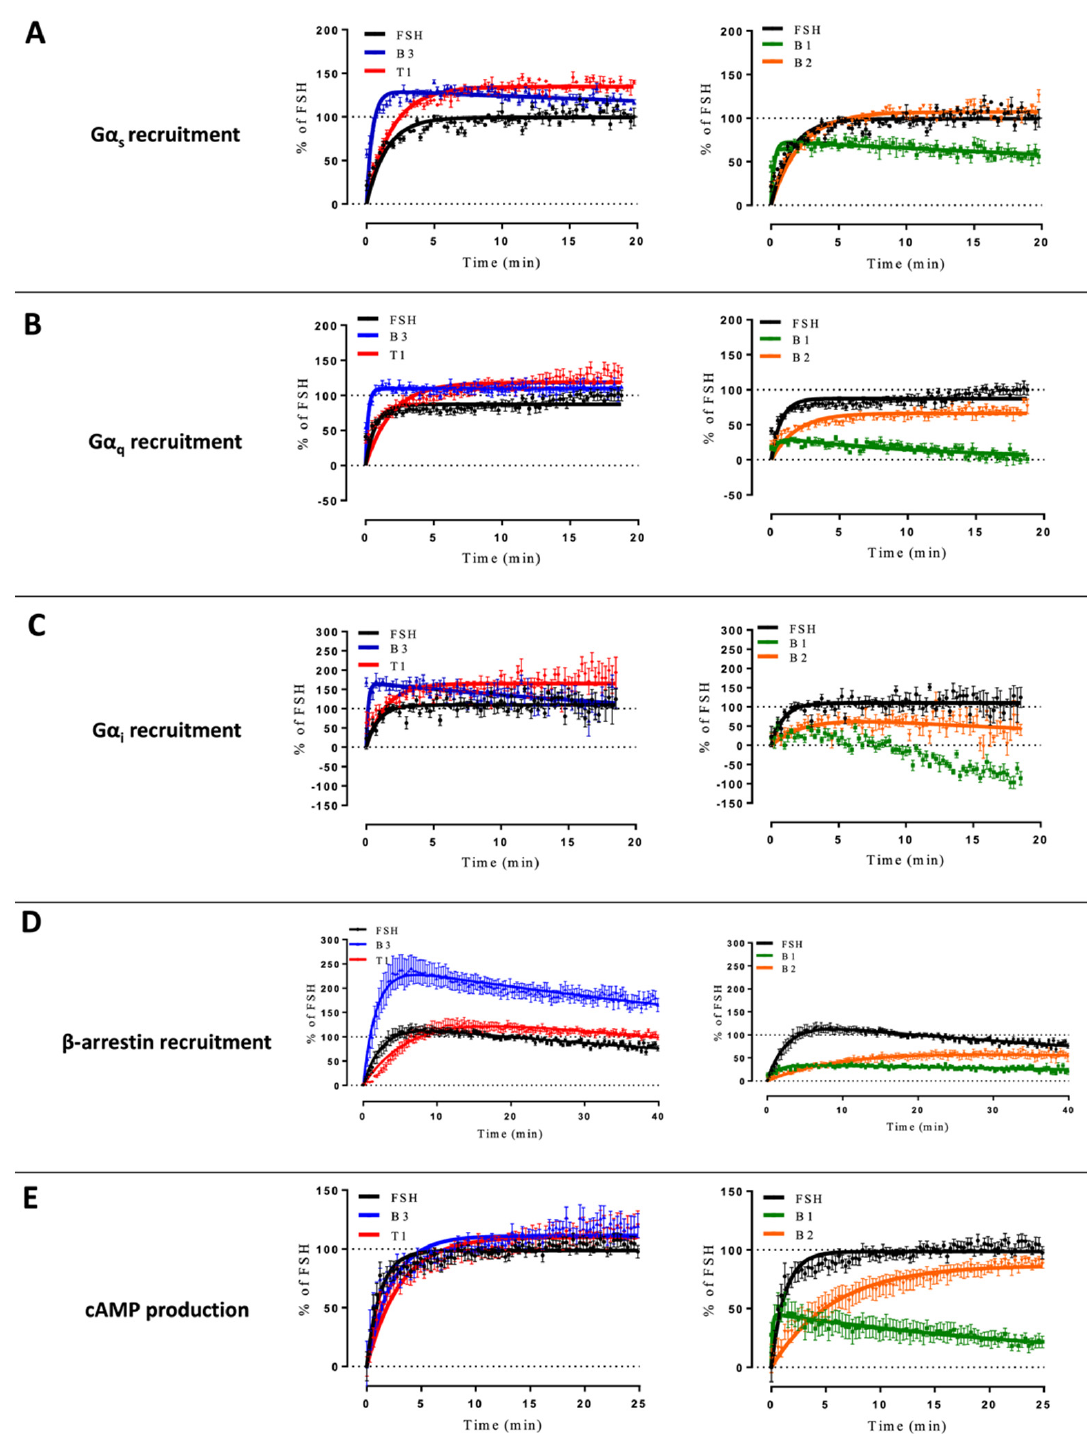
Figure 3. Kinetics curves induced by EC80 of FSH and LMW ligands. ( A ) G α s recruitment, ( B ) G α q recruitment, ( C ) G α i recruitment, ( D ) β -arrestin 2 recruitment, and ( E ) cAMP production were measured. HEK293 cells transfected with FSHR and appropriate BRET sensors were stimulated with EC 80 of FSH or LMW ligands. Signals were monitored for 20 to 40 min, depending on the read-out. Kinetic curves corresponding to each read-out were normalized considering the signal elicited by FSH at 20 min as 100%. Kinetics curves were plotted as a function of time. Data are represented as mean ± SEM from at least six independent experiments.